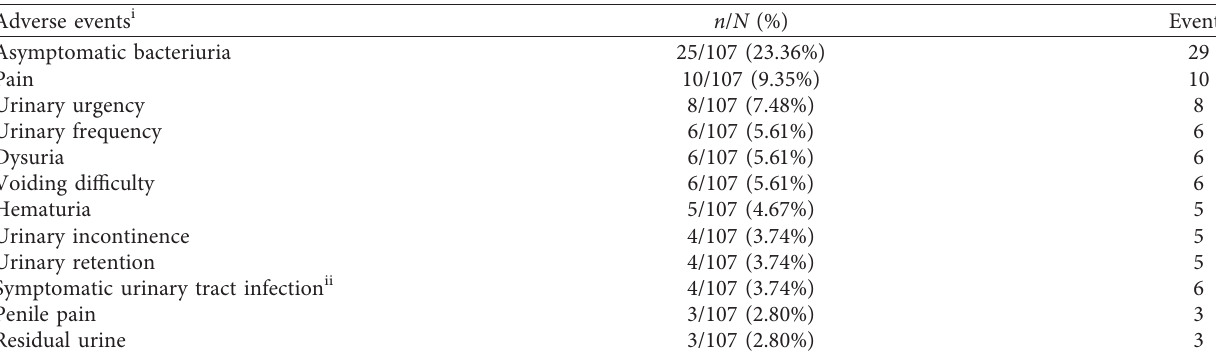
Table 7: Adverse events related to the procedure/device.